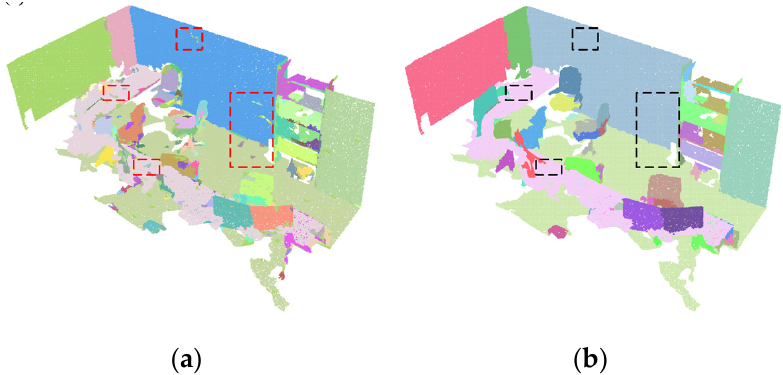
Figure 3. The illustration of the indoor segmentation result: ( a ) the segmentation result after the multi-constraint graph clustering, ( b ) the segmentation result after the post-refinement.